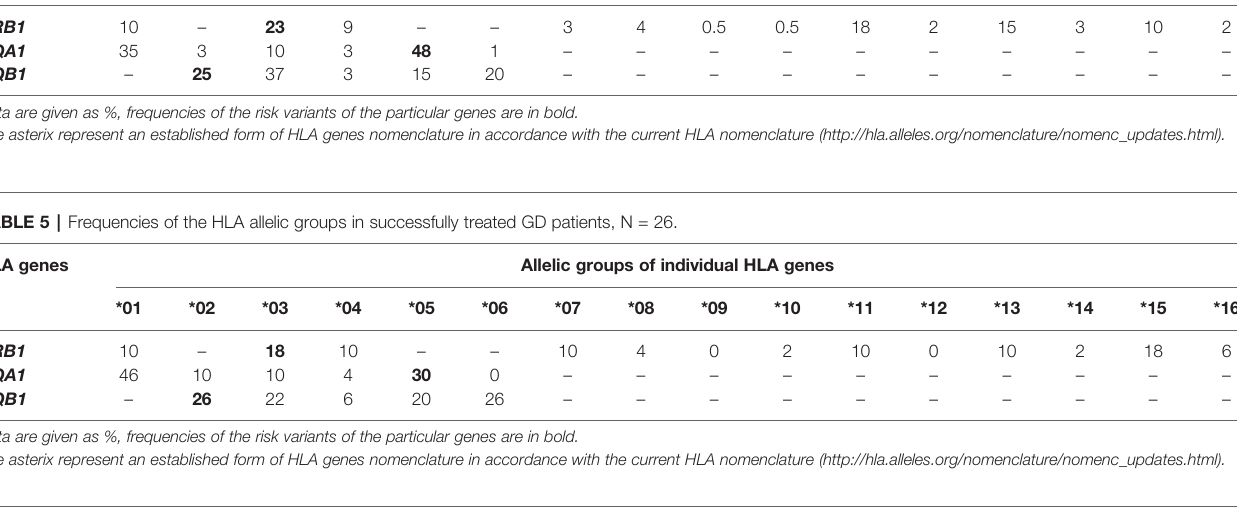
TABLE 6 | Frequencies of the HLA allelic groups in GD patients whose success of treatment could not be evaluated, N = 93. HLA genes